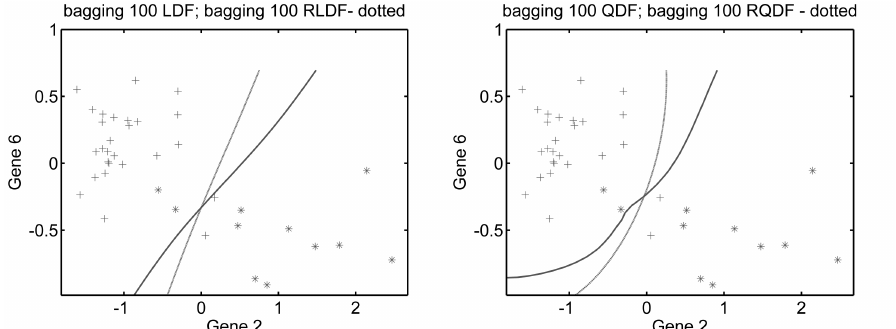
Figure 10. Final classification boundaries after 100 loops of bagging for linear LDF and RLDF (left and dotted: apparent, CV and L1o errors = 0.105) and QDF with RQDF (right and dotted: apparent error, CV = 0.105 with SD = 0.07, L1o =